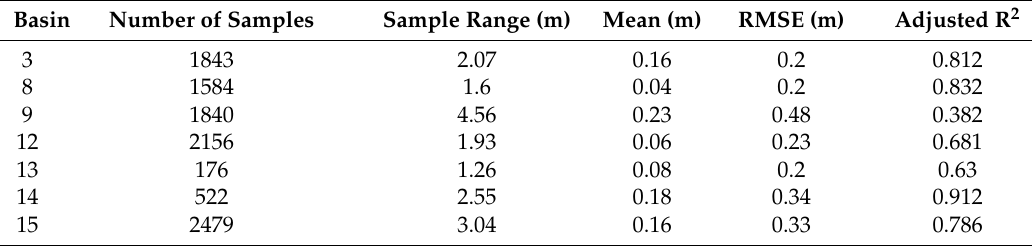
Table 7. Sonar-reading correlation results for Lidar-derived patch elevations at